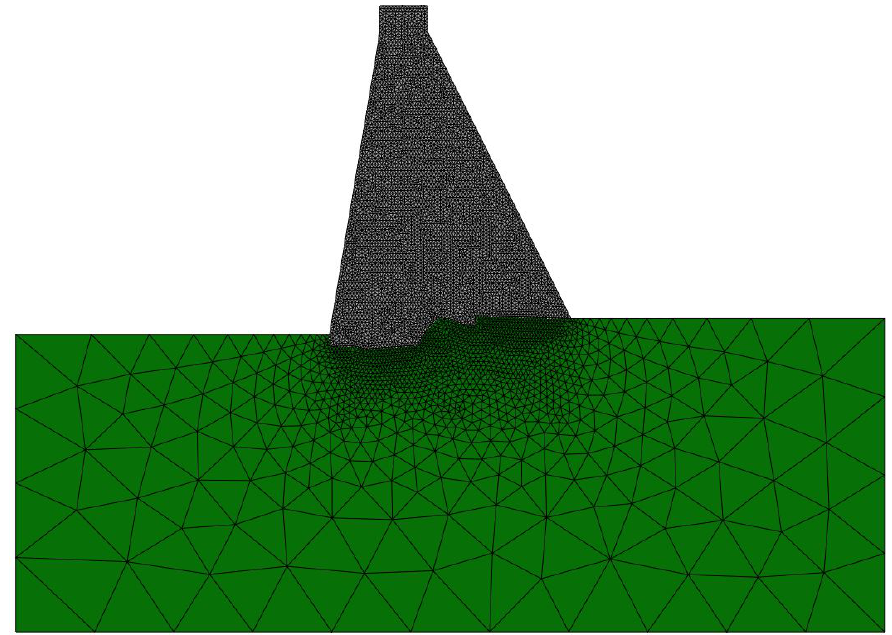
Figure 8. Finite element model for the dam foundation